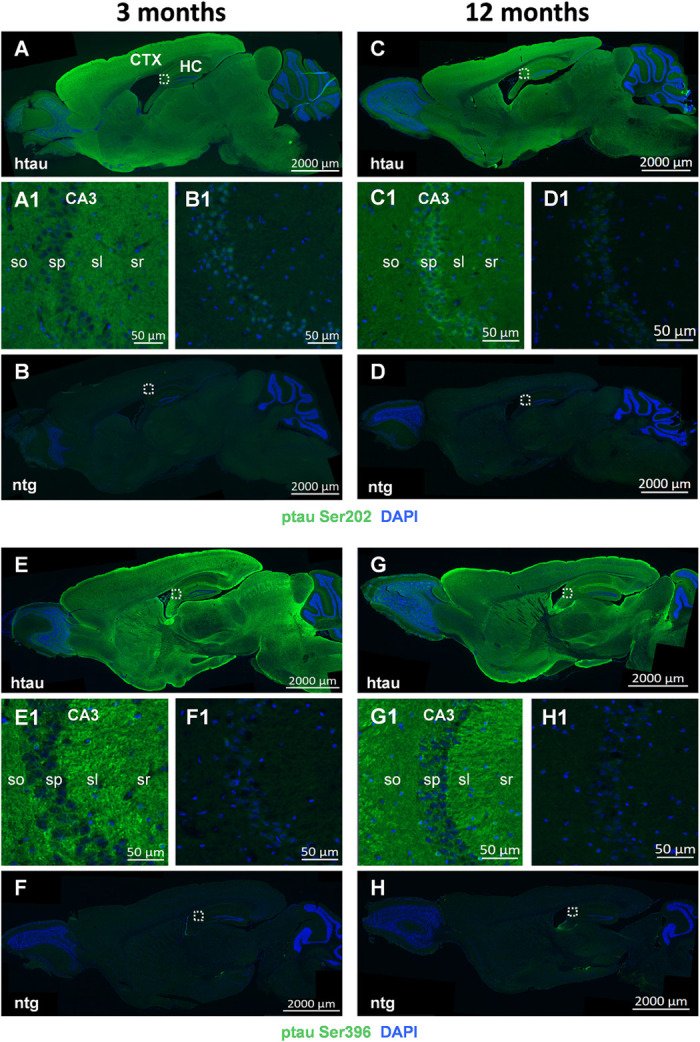
Representative images of ptau Ser202 and ptau Ser396 in the brain of 3 and 12 month old htau mice. Immunofluorescent labeling of ptau Ser202 (A–D; green) and ptau Ser396 (E–H; green) on sagittal sections of 3 (A,E) and 12 (C,G) month old htau mice compared to age-matched ntg controls (B,F,D,H). Very high signal is evident in the frontal cortex of htau mice. Immunofluorescence is absent from ntg tissue except for minor unspecific signal in the nuclei. Magnified areas in (A1–H1) show hippocampal CA3 region as indicated in the whole slide scan. Nuclei are labeled by DAPI (blue). So, stratum oriens; sp, stratum pyramidale; sl, stratum lucidum; sr, stratum radiatum. Scale bar: (A–H): 2,000 μm. (A1–H1): 50 μm.